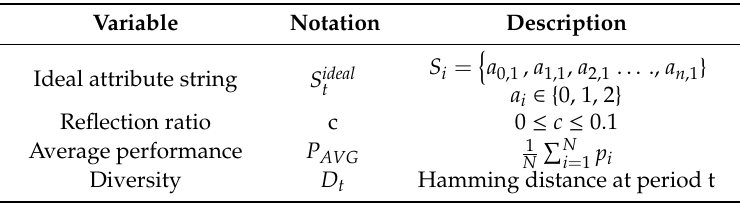
Table 4. The list of attribute in the ecosystem layer.